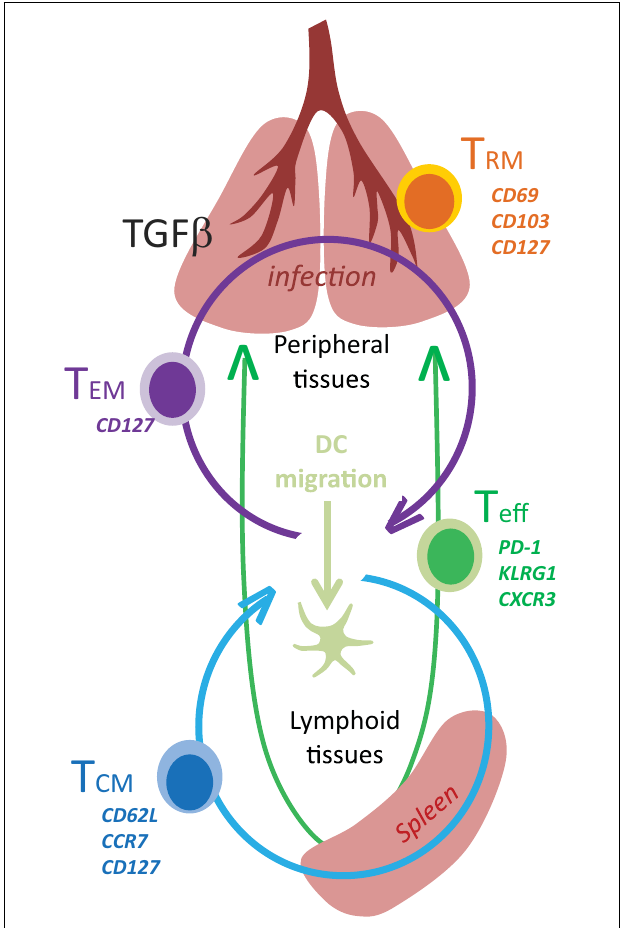
FIGURE 1 |Tissue distribution of memory CD8T cells